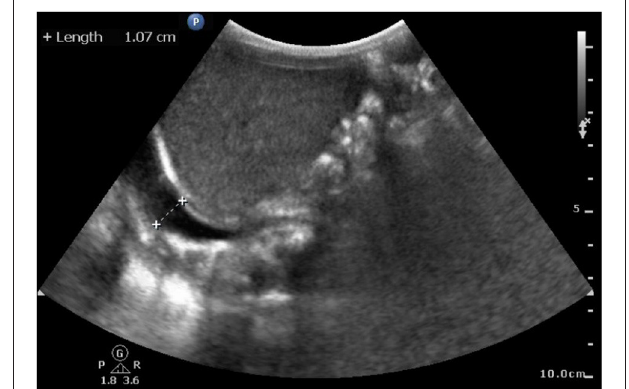
FIGURE 2 | Sonography at 43 days of age. Hemothorax detected by chest sonography after first discharge without prophylaxis. Image shows the accumulation of clear fluid in the right pleural cavity under infra-hepatic